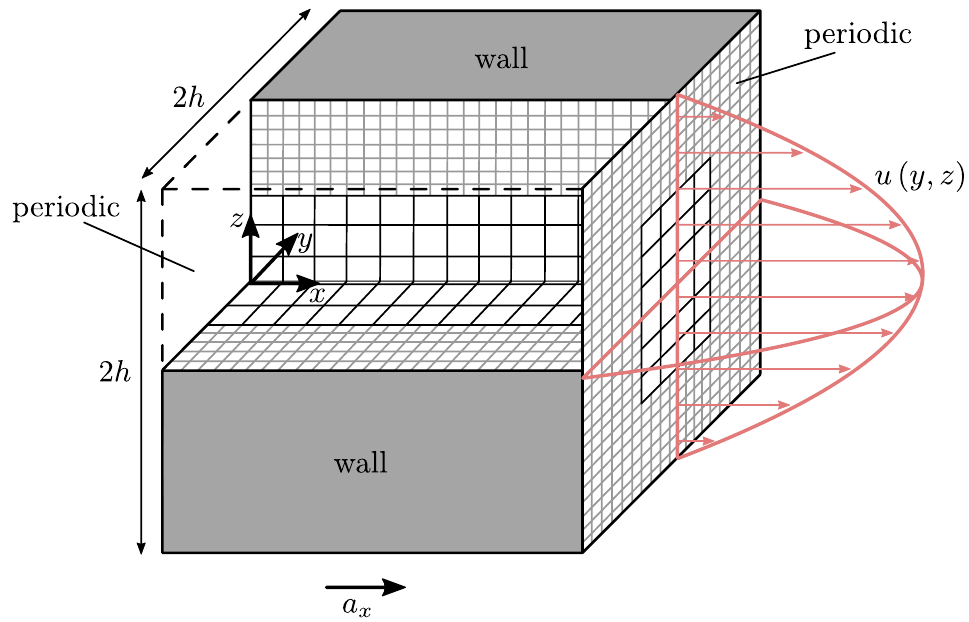
Figure 9. Schematic representation of the calculation domain for the square duct test